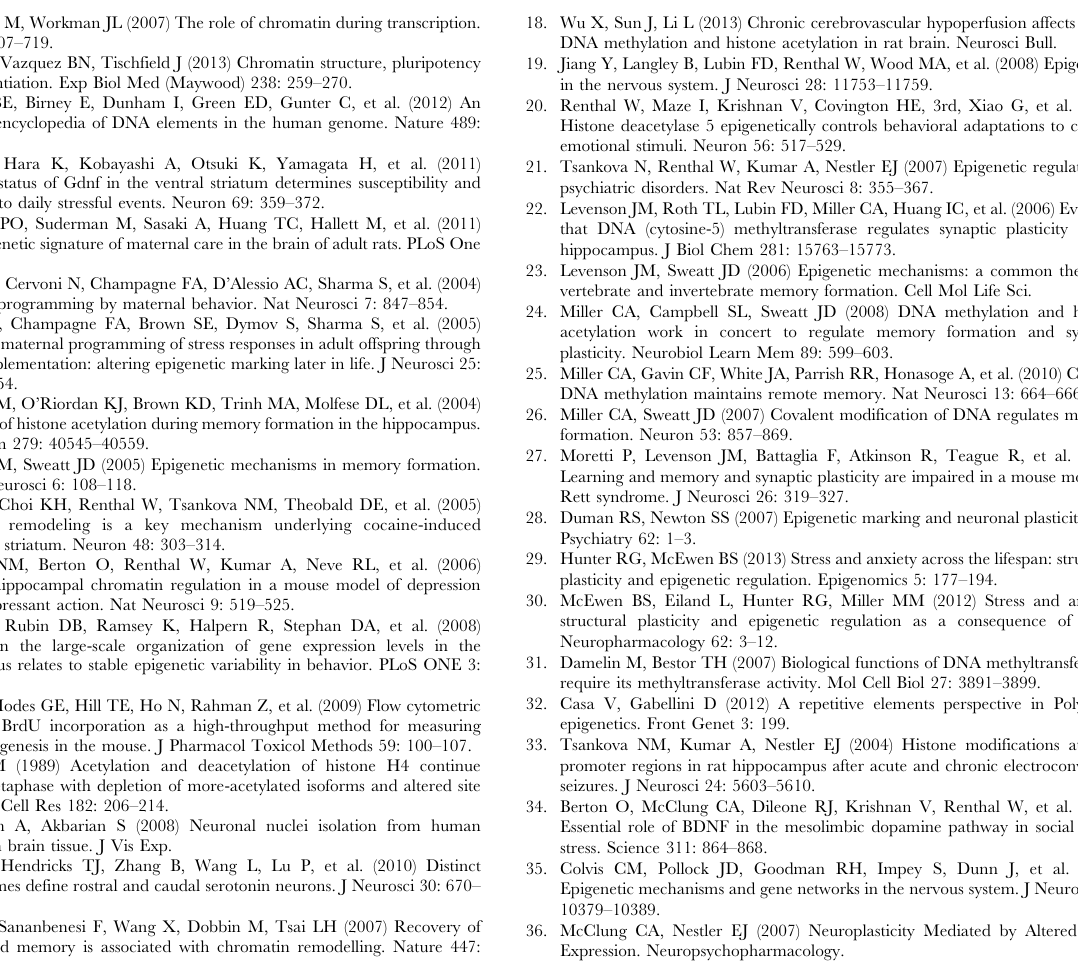
Table S2 Spearman correlations of open-field behav- ioral measures with regional measurements of AcH3. Table shows the Spearman-r values for the correlations between total levels of histone acetylation in 3 brain regions and levels of five open-field measures (percent distance in the center, total distance in the center, time spent in the center, entries into the center, and total distance travelled) across three testing sessions over 28 days. Spearman correlations were used because behavioral measures were often not normally distributed. Sessions 1 and 3 were conducted in direct light and session 2 was done in the dark there were significant correlations of all center measures tested in the light on days 1 and 28 with AcH3 in the hippocampus. There that had very low